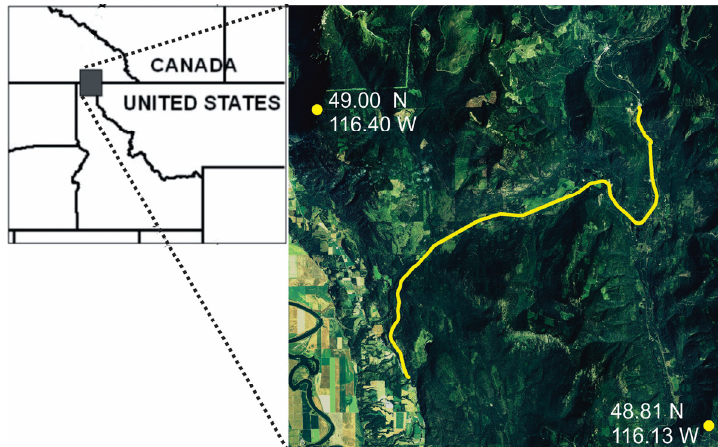
Figure 1. Study area orientation map. The study area is approximately 1,500 square kilometers in the Purcell Mountains of northern Idaho. This study focuses on the section of U.S. Highway 95 from the junction of Highway 1 in Idaho to the Canadian border (yellow